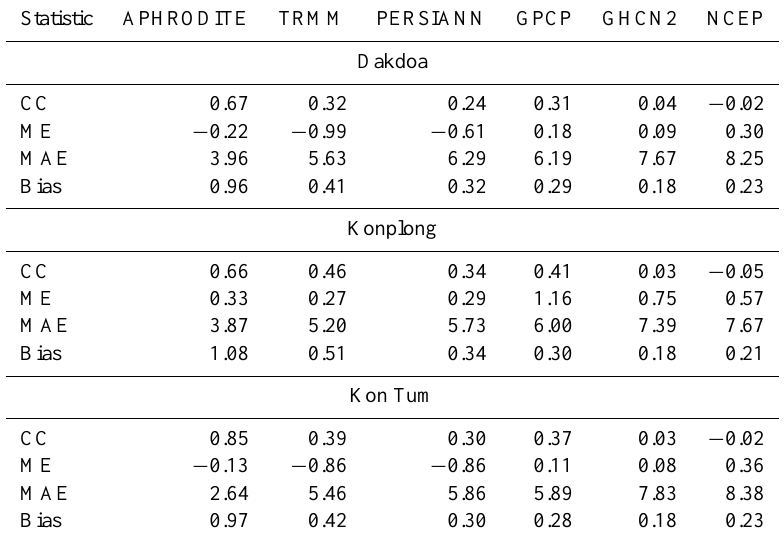
Table 3. Comparison statistics of gridded data with reference to local station for daily value over 5-yr period 2001–2005. Statistic APHRODITE TRMM PERSIANN GPCP GHCN2 NCEP Dakdoa CC 0.67 0.32 ME − 0.22 −